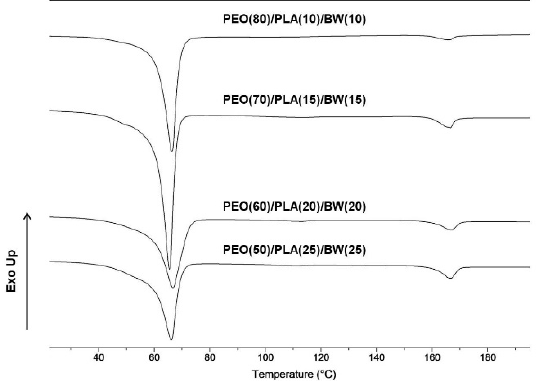
Figure 6. DSC thermograms (first heating run) of PEO/PLA/BW fibrous materials prepared at different weight ratios, registered using Discovery DSC 250 (TA, Instruments, New Castle, DE, USA). Two melting peaks at ca. 65 ºC and 166 ºC were registered in DSC thermograms. The first peak is attributed to the melting of PEO and BW. PEO and BW melt in a very close temperature range: PEO is characterized by a narrow melting peak and has melting temper- ature of ca. 65 ºC, while BW melts in a broad temperature range (from ca. 40 ºC to 70 ºC). This makes it difficult to distinguish the melting peaks of PEO and BW. The registered second peak at 166 ºC in the thermograms was attributed to PLA melting in the composite PEO/PLA/BW fibrous materials. As seen from Figure 6, upon increasing the BW content in the composite fibrous materials, the melting peak at ca. 65 ºC broadened. The melting enthalpies of PLA and PEO/BW in the composite fibrous materials as determined by DSC are listed in Table 2. Using the PLA melting enthalpy, the PLA crystallinity in the compo- site fibers was estimated, taking into account the PLA weight fraction in the mat. As seen, for PEO/PLA/BW fibrous materials, the PLA crystallinity degree was close to 50%. Table 2. Melting temperature and enthalpy of PLA and PEO/BW, registered by DSC. PLA crystal- linity degree in the composite fibrous materials. 102 (a) PLA crystallinity degree in the composite fibrous materials was calculated using the following equation: χ cPLA , % = [ Δ H mPLA ]/( Δ H mPLA,0 × W PLA )] × 100, where Δ H mPLA,0 = 93.0 J/g [40], and W PLA was the weight fraction of PLA in the composite fibrous materials. The amorphous/crystalline structure of PEO/PLA/BW fibrous materials was evalu- ated by X-ray diffraction analyses (XRD). The registered XRD patterns are shown in Fig- ure 7. PEO is a semi-crystalline polymer, having diffractions at 19.2º and 23.3º [41]. Dif- fractions at 21º and 24° are present in XRD patterns of BW [42,43].